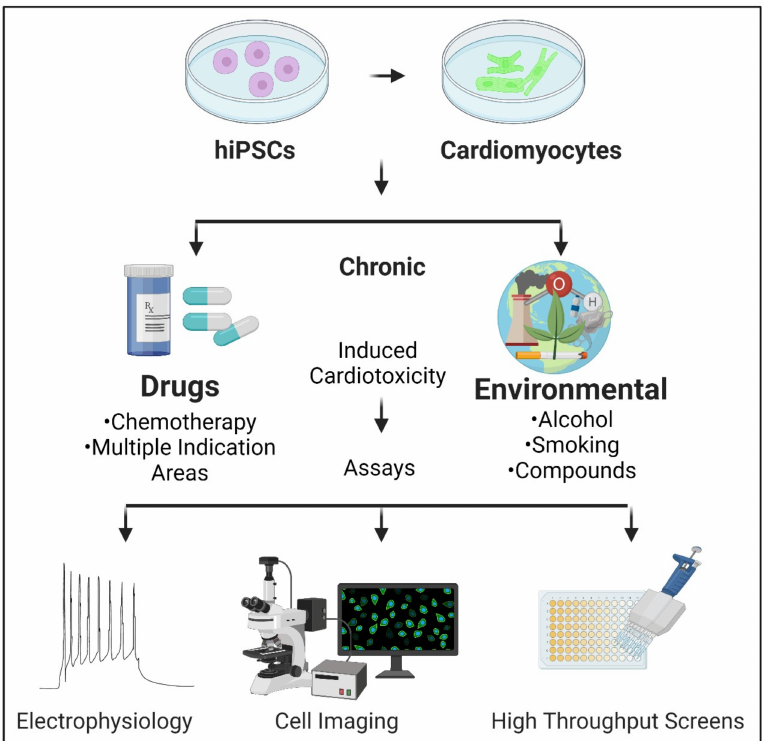
Figure 1. Cardiotoxicity screening using human induced pluripotent stem cell (hiPSC) derived cardiomyocytes post prolonged